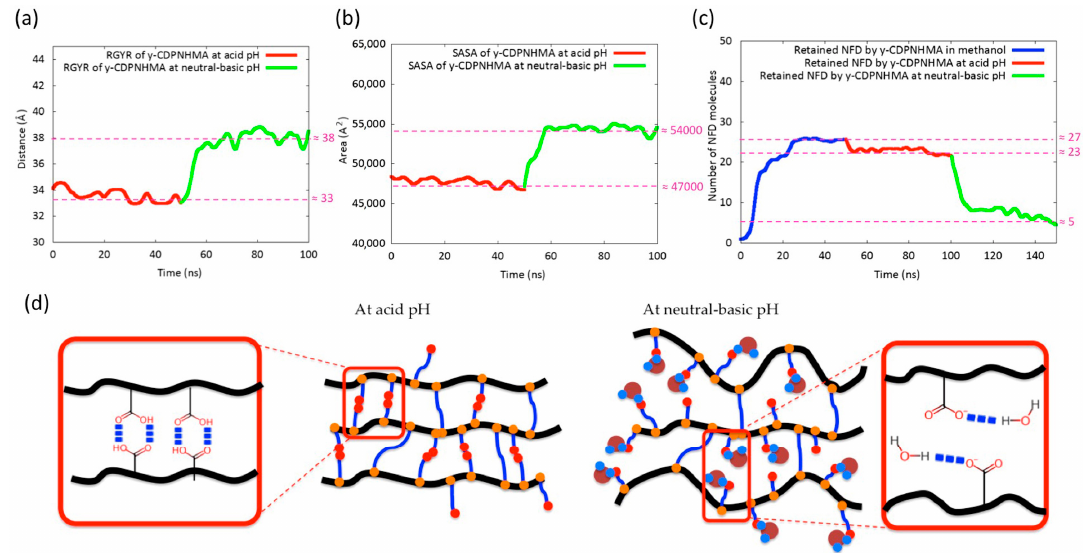
Figure 3. ( a , b ) Radius of Gyration (RGYR) and Solvent Accessible Surface Area (SASA) plots of the γ -CDPVAHMA at acid (0–50 ns) and neutral-basic pH (51–100 ns), respectively. ( c ) Number of NFD molecules retained by γ -CDPVAHMA during the three simulations: in methanol (0–50 ns), at acid pH (51–100 ns) and at neutral-basic pH (101–150 ns). ( d ) Schematic representing the possible interactions between carboxylic groups at acid pH (formation of hydrogen bonds) and hydrogen bonds between deprotonated carboxylic groups and water molecules at neutral-basic pH.